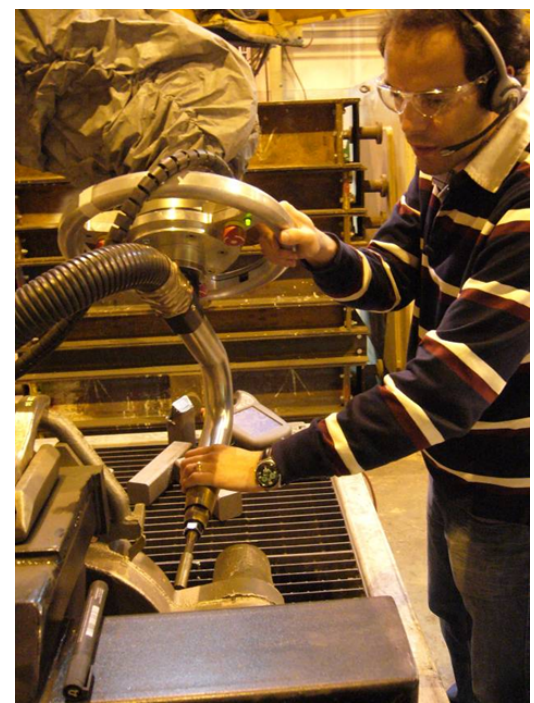
Figure 6: Lead through programming of cutting of a steel casting (using an oxy-fuel burner). The operator makes use of both hands to control the position and orientation of the tool while speech communication is used to define the robot tasks. A 6 DOF force/torque sensor between the tool and the robot wrist is in- cluded in a feedback loop to control the tool to move according to the intentions of the op- erator. The wheel contains distributed safety switches making it possible for the operator to have access to the safety system from all